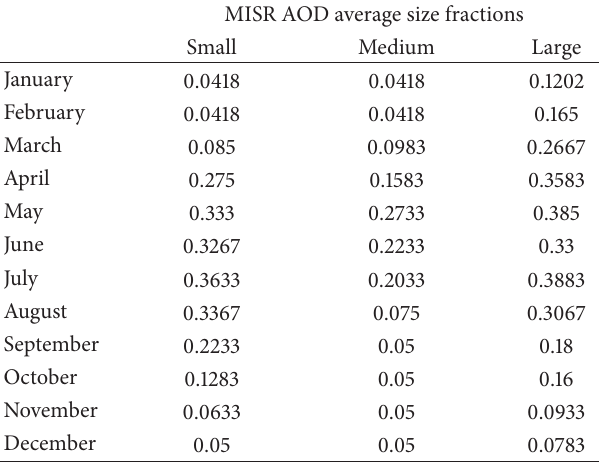
Table 2: MISR AOD monthly mean size fractions for the period